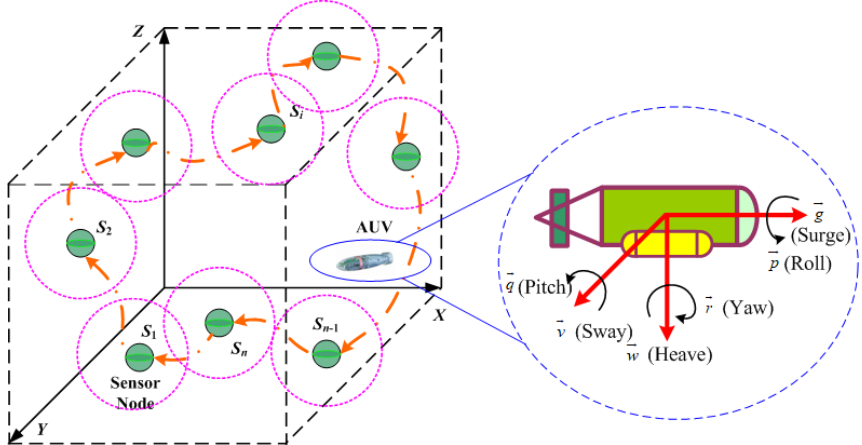
Figure 1. Network topology and dynamics of autonomous underwater vehicles (AUVs) ( n = 10 sensor nodes and one AUV deployed randomly in a three-dimensional underwater